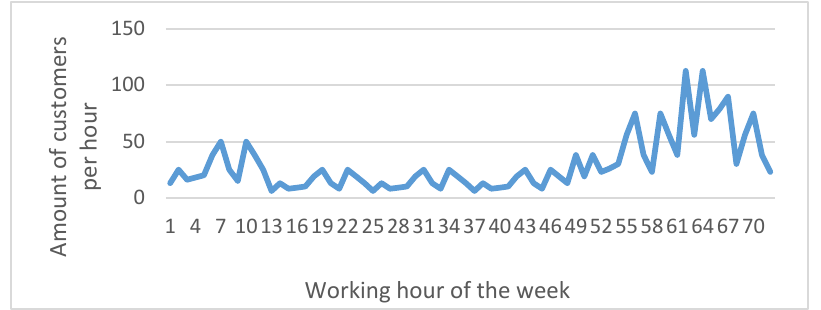
Figure 7. Simulated number of customers per hour for the whole week.